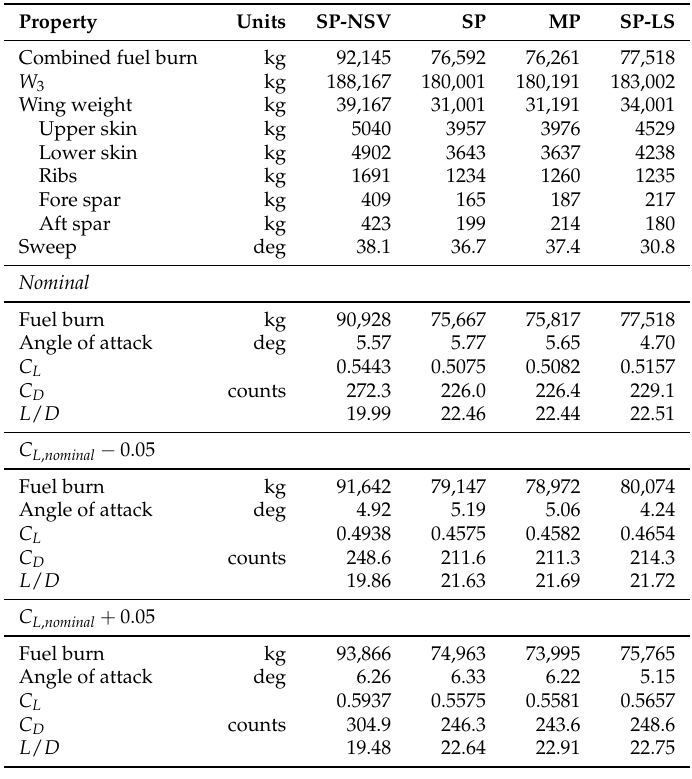
Table 7. Optimization